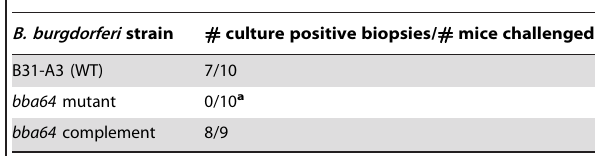
Table 2. Borrelia burgdorferi mouse skin biopsy cultures, following feeding of infected nymphs contained within a capsule.